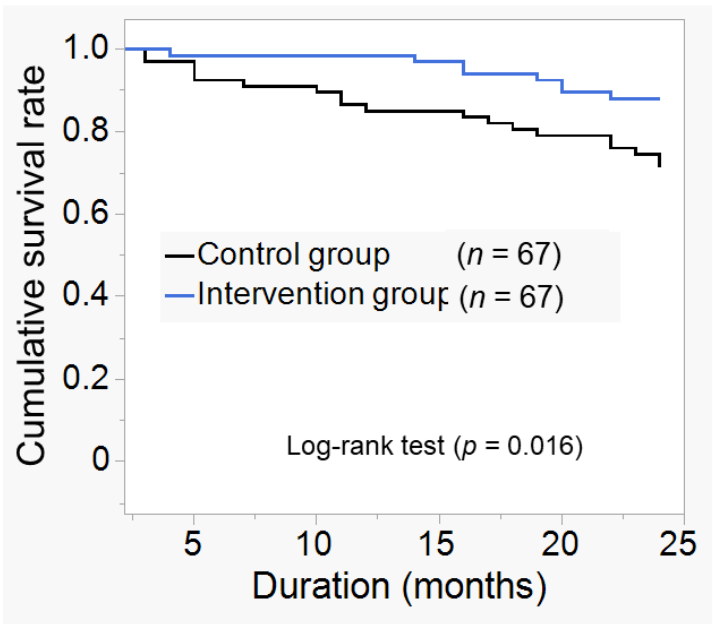
Figure 2. Kaplan–Meier curve for new event incidence. Cumulative survival rates for the composite endpoint included new cardiovascular disease (CVD) and stroke, hemodialysis (HD) induction, and all-cause mortality at 24 months compared to the two groups. The definition of CVD was myocardial infarction, ischemic heart disease, heart failure, peripheral arterial disease, and arrhythmia. After 24 months of observation, the cumulative survival rate for new events was 0.881 in the intervention group and 0.715 in the control group, and was significantly higher in the intervention group ( p = 0.016). Table 2. Breakdown of newly generated events.